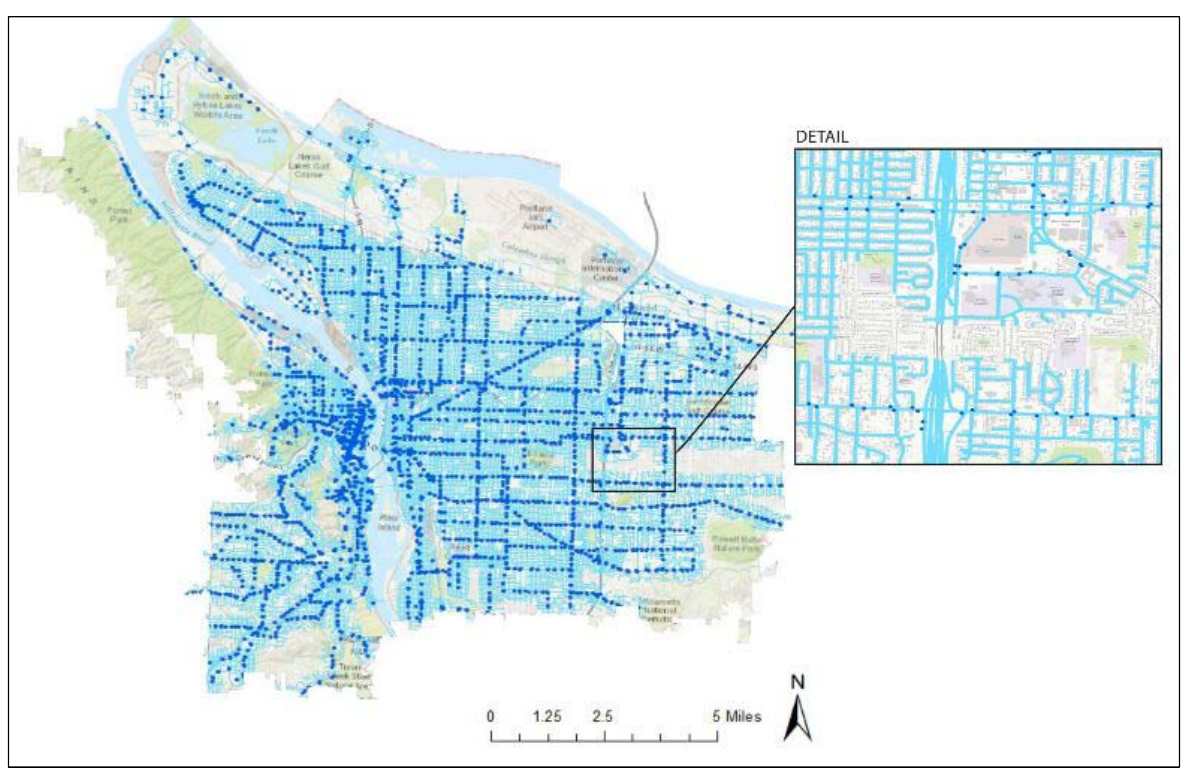
Figure 7. Street Network Visualization of Bus Stop Service Areas with Detail of Coverage Gaps in East